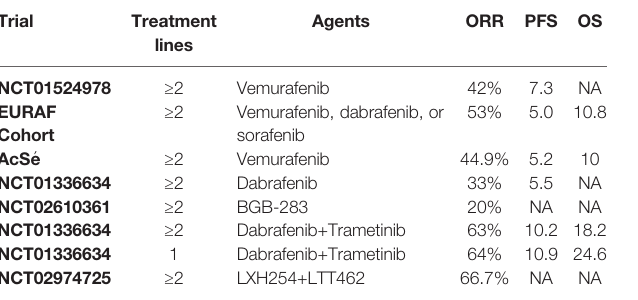
TABLE 2 | Targeted therapy for BRAF-mutated NSCLC.